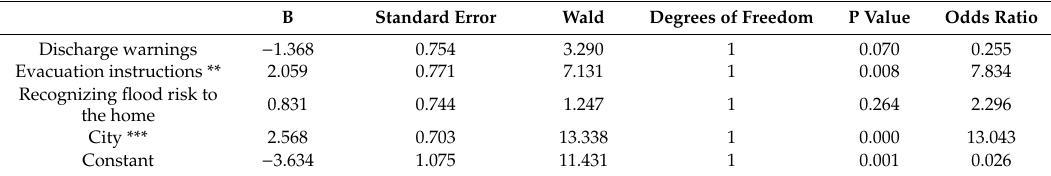
Table 5. Variables related to early evacuation (1) (logistic regression analysis).